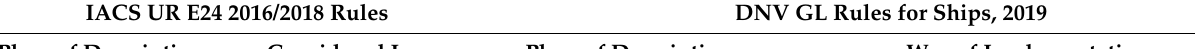
Table 2. Implementation of the IACS UR E24 2016/2018 rules [5], based on a case study of DNV GL 2019 [6]. IACS UR E24 2016/2018